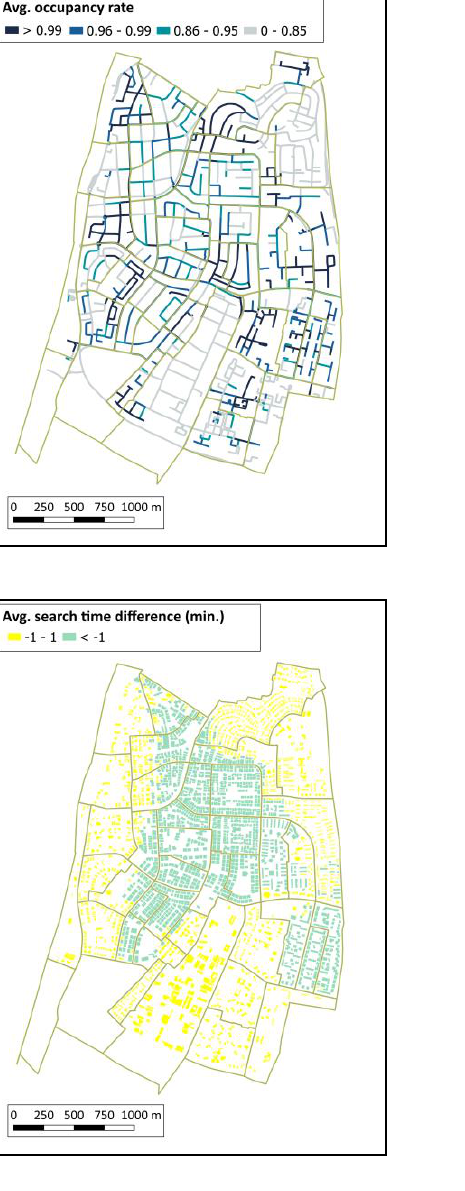
Figure 12. Characteristics of Bat Yam TAZ-based pricing: Average occupancy rate by links (upper-left); average parking search time (upper-right); average difference in search times compared to non-priced parking (lower-left); probability to cruise longer than 2.5 minutes